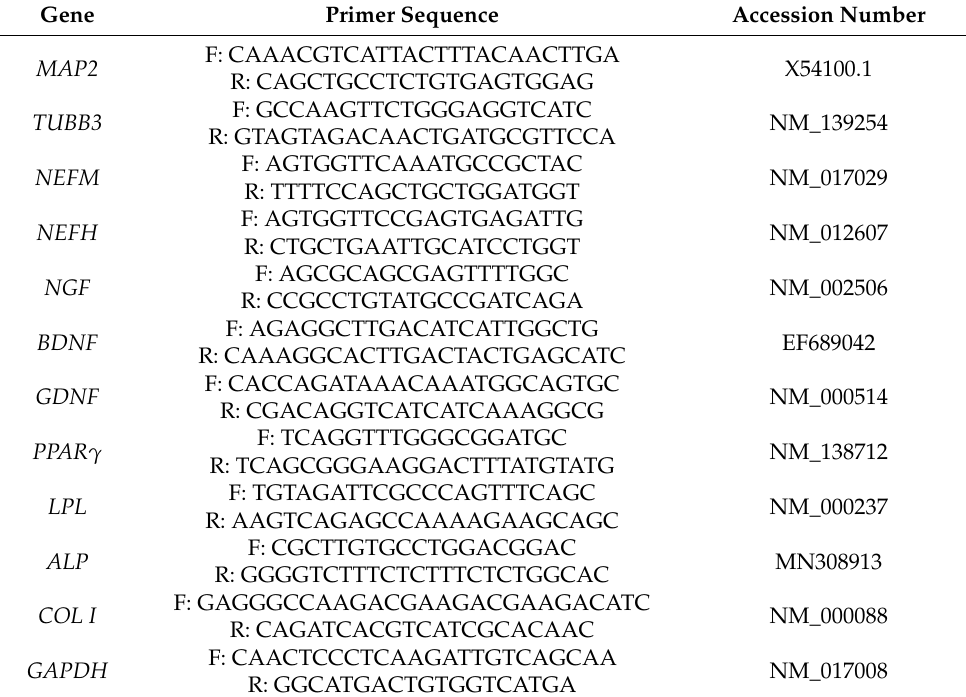
Table 1. Primer sequences used in this study for the RT-qPCR